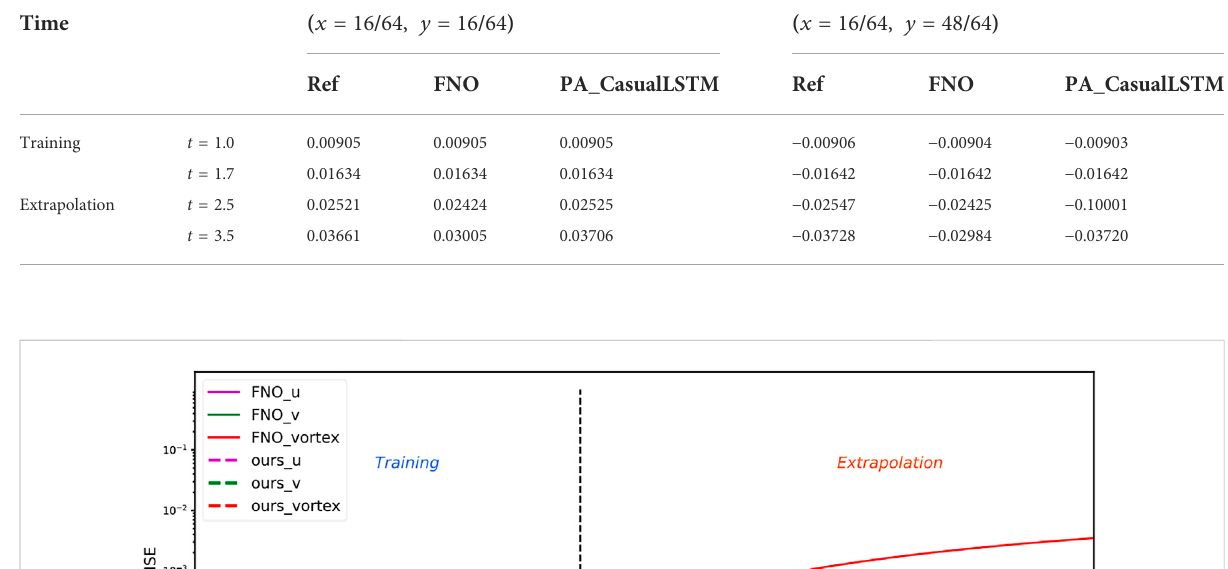
TABLE 4 Numerical results of velocity ( v ) for 2D Navier – Stokes equations solved by the classical numerical method, FNO, and PA_CasualLSTM.